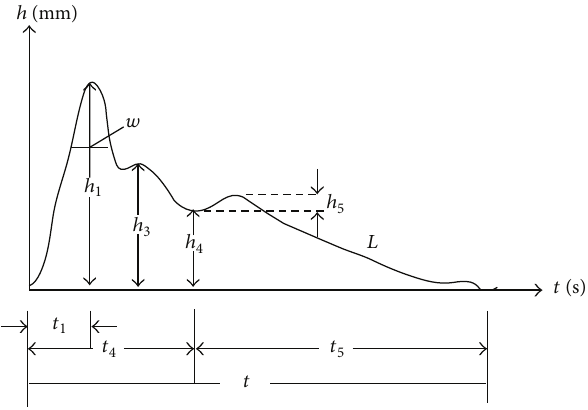
Figure 1: Basic structure of pulse